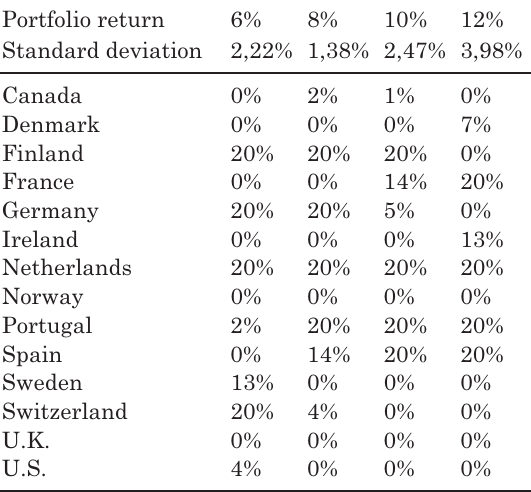
Table 10. Asset allocation in effi cient international